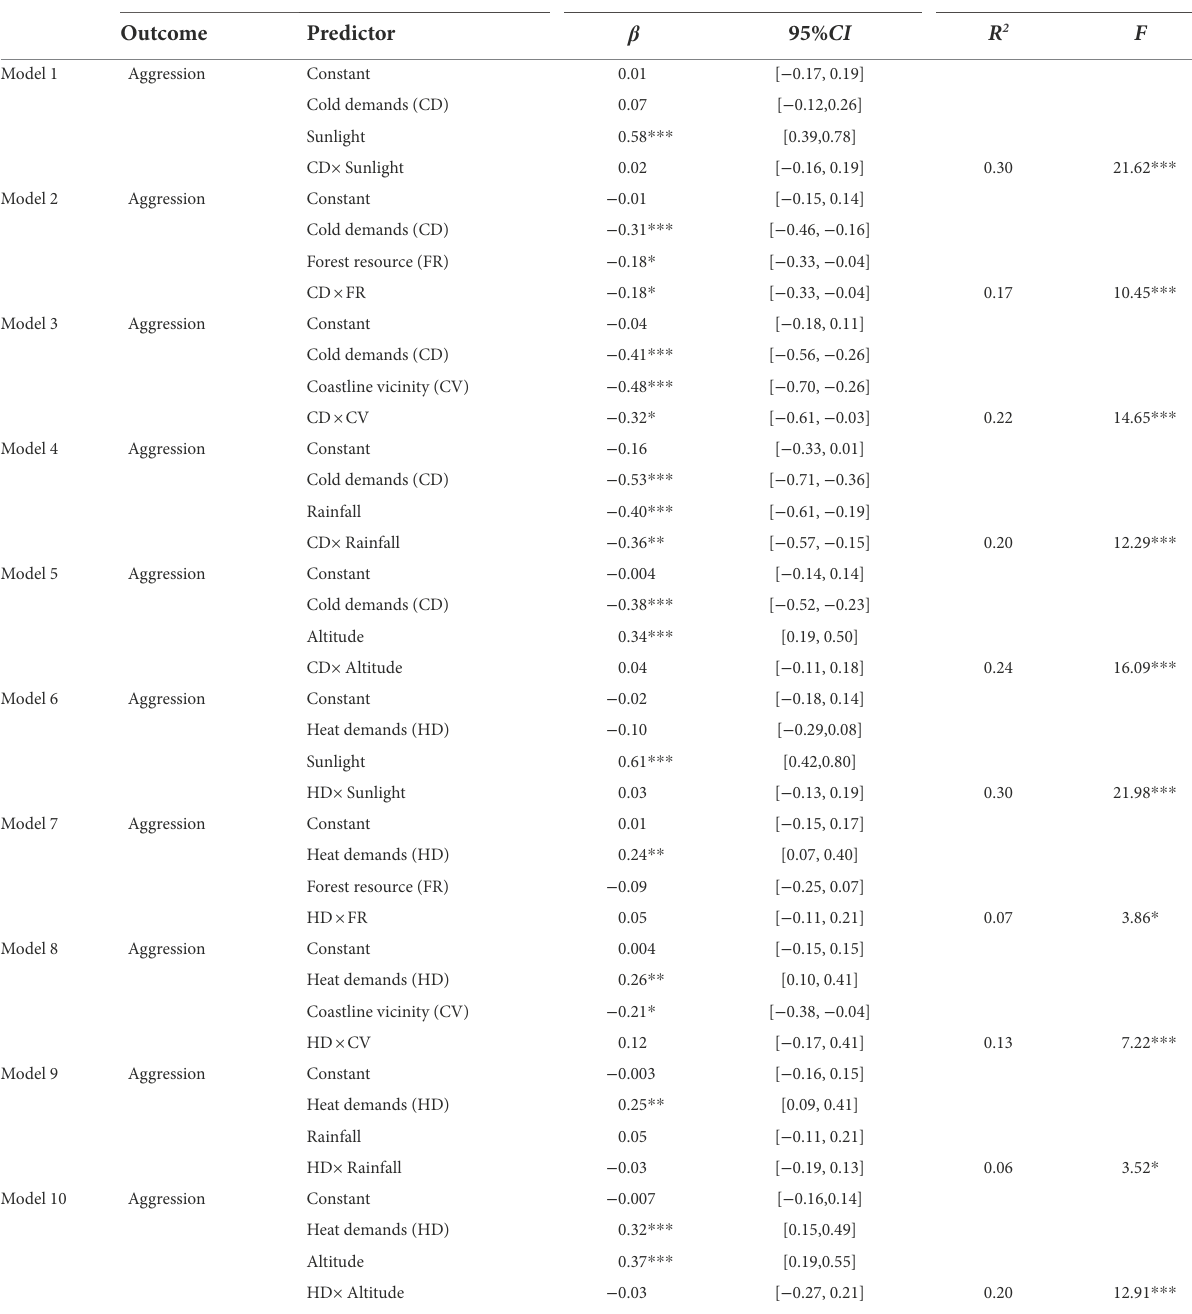
TABLE 2 Moderating effects analysis ( N =